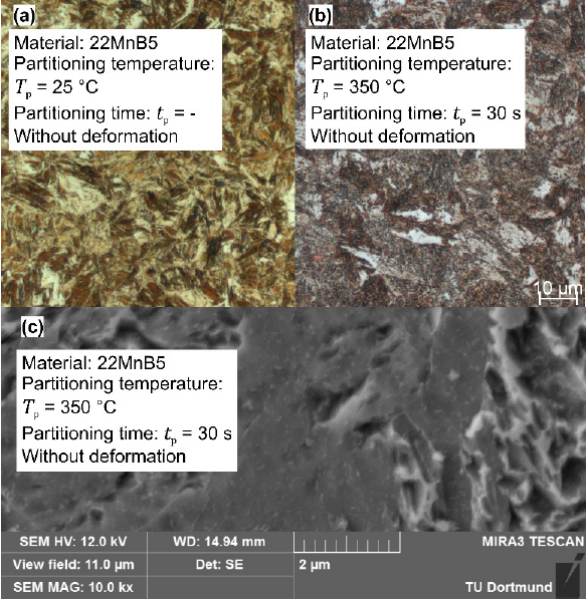
Figure 9: Microstructure analysis of 22MnB5: (a) Step 1: Quench- ing to room temperature; (b) Step 2: Quenching to 350 ∘ C during 30s ; (c) Formation of carbides. Reprinted with permission from